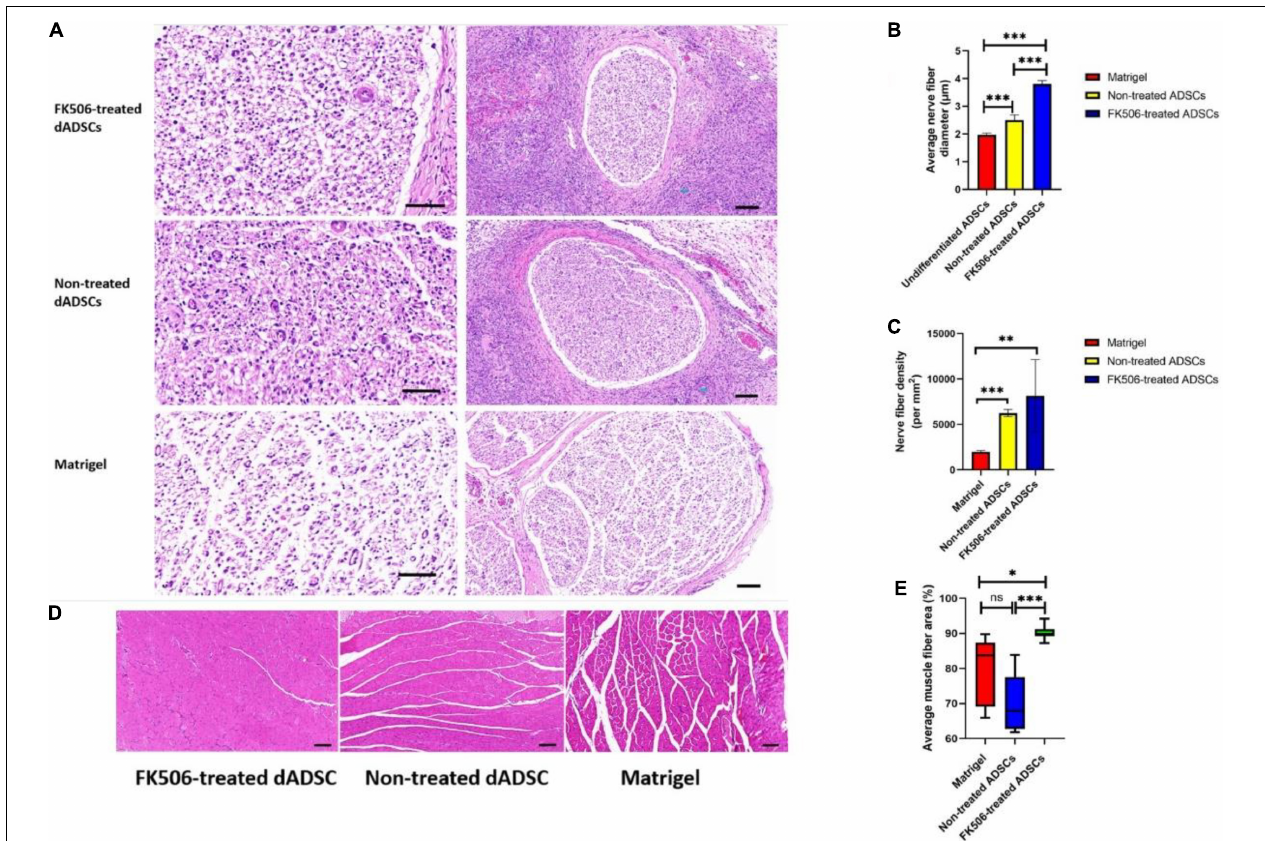
FIGURE 6 | (A) Histological evaluation of regenerated nerves at 3 weeks after cell transplantation. The scale bar in left column figures is 50 and the right is 100 µ m. (B,C) The nerve fiber diameter and density evaluation in different groups. ∗∗ P < 0.01, ∗∗∗ p < 0.001. (D) Representative HE staining results of the gastrocnemius showed muscle fibers and the collagen fibers distributed among them. Scale bar 100 µ m. (E) The muscle fiber area in different groups. ∗ P < 0.05, ∗∗∗ p <